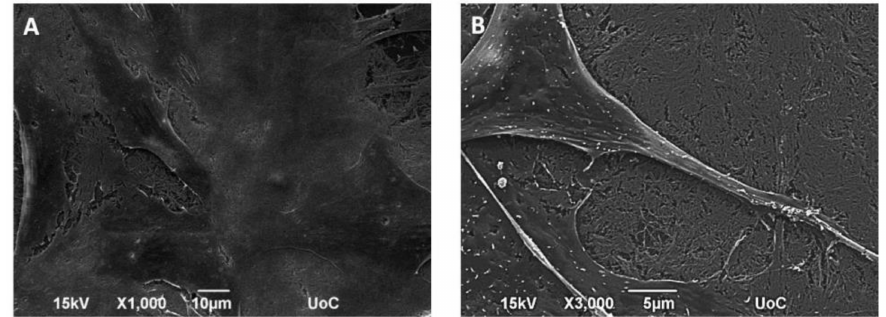
Figure 6. SEM images show the morphology of MC3T3-E1 cells after 1 day of culture spreading onto fibrous collagen; images with different magnifications, 1000 × ( A ) and 3000 × ( B ) indicate a fully flattened pre-osteoblastic cell morphology and cell protrusions,